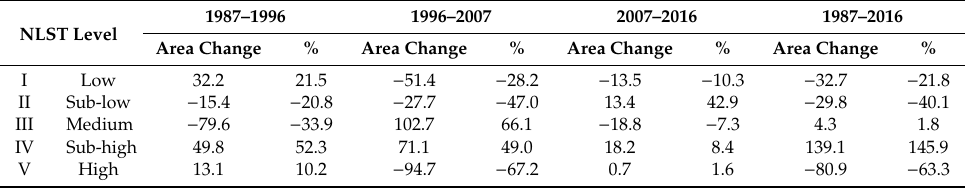
Table 3. Area changes (km 2 ) of each NLST level during four observed sub-periods in Wuhan.